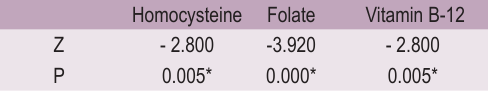
TABLE 2. Comparison of serum concentration of homocys- teine, folate and vitamin B-12 in shizophrenia patients and control group.